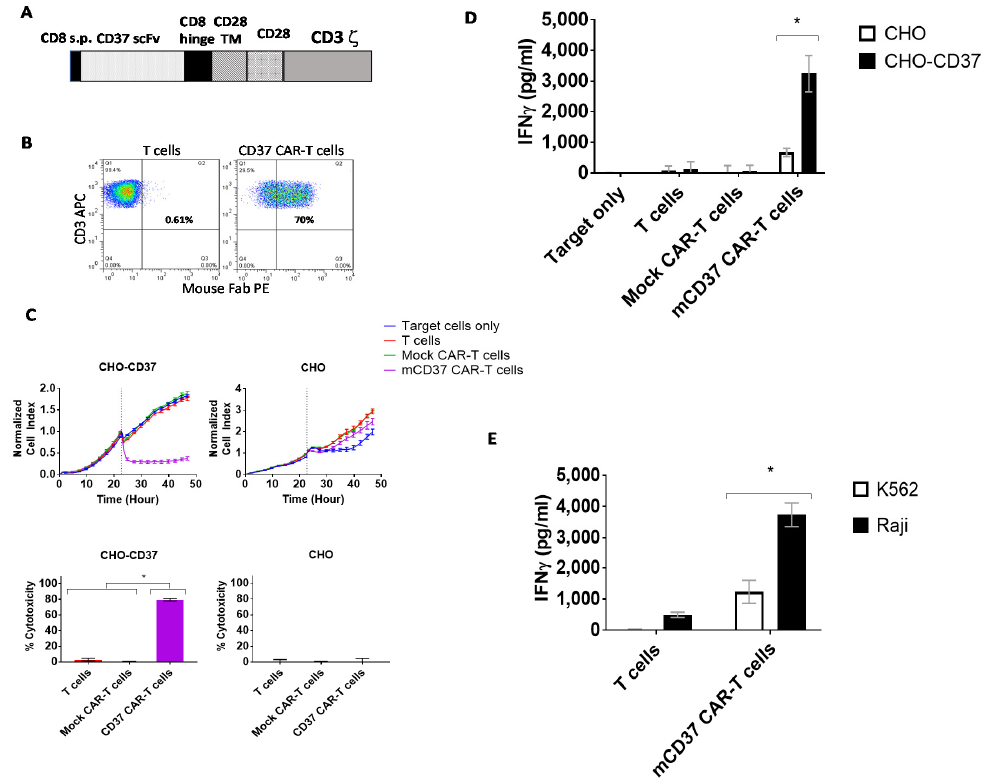
Figure 2. The specific CD37-chimeric antigen receptor (CAR)-T cell activity against CD37-positive cells in vitro. ( A ). The structure of CD37-CAR. The mouse ScFv (single-chain variable fragment) was used with CD8 hinge, CD28 transmem- brane/costimulatory domains, and CD3 zeta activation domain. CD8 s.p-CD8 alpha signaling peptide; TM-transmembrane. ( B ). FACS with mouse F(ab)2 antibody (mFAB) detected CAR-positive cells. ( C ). Real-time cytotoxicity assay (RTCA) showed specific killing activity of CD37-CAR-T cells against CHO-CD37 cells but not CHO cells (upper panels). Lower panels: Percent cytotoxicity calculated at the end of the experiment. Significantly high cytotoxicity was observed against CHO-CD37 for CD37-CAR-T cells. p < 0.0001, One-Way ANOVA followed by Sidak multiple comparisons test. ( D ). Interferon-gamma (IFN- γ ) secretion by CD37-CAR-T cells against CHO-CD37 cells is significantly higher than against CHO cells. asterisk *, p < 0.0001, two-way ANOVA p <0.0001, followed by Tukey’s multiple comparison test. ( E ). Secretion of IFN-gamma by CD37-CAR-T cells is significantly higher with Raji cells than with CD37-negative K562 cells. asterisk *, p < 0.005, mCD37 CAR-T cells with Raji cells versus same CAR-T cells with K562 cells, Student’s t